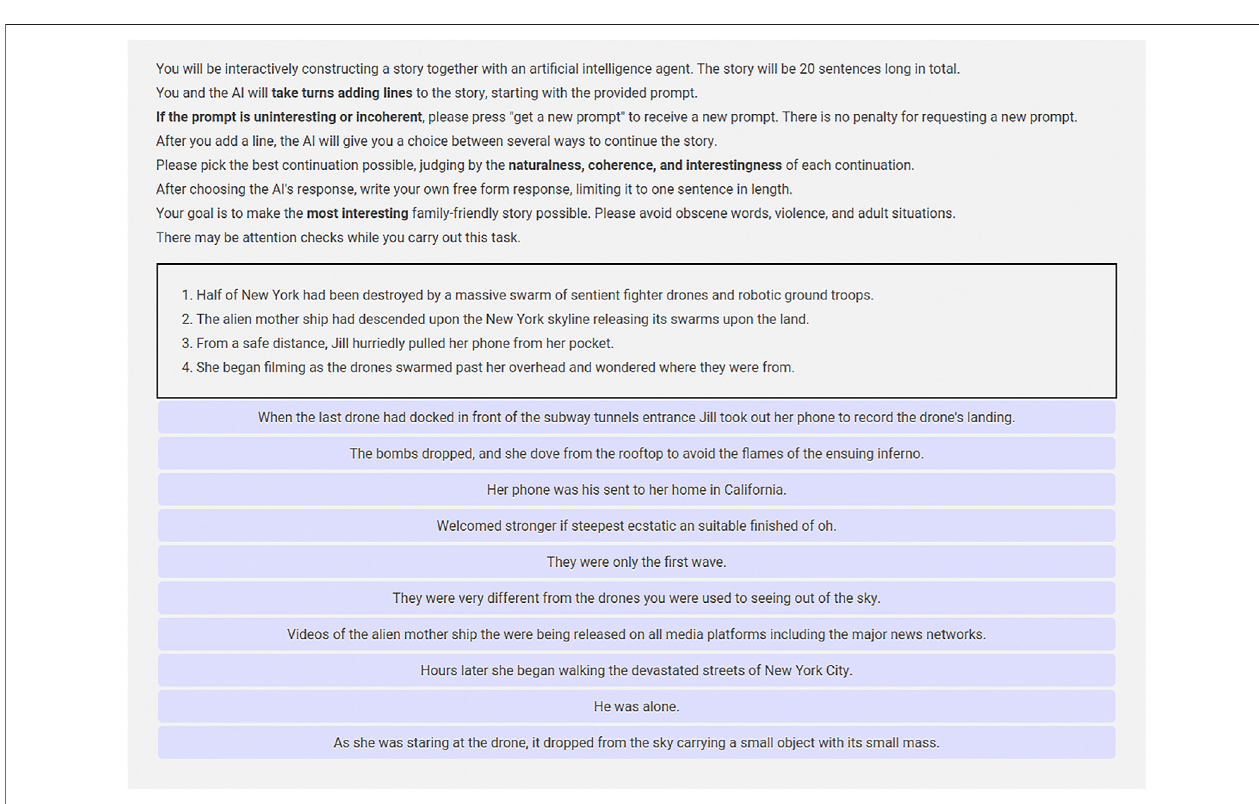
Frontiers in Computer Science |